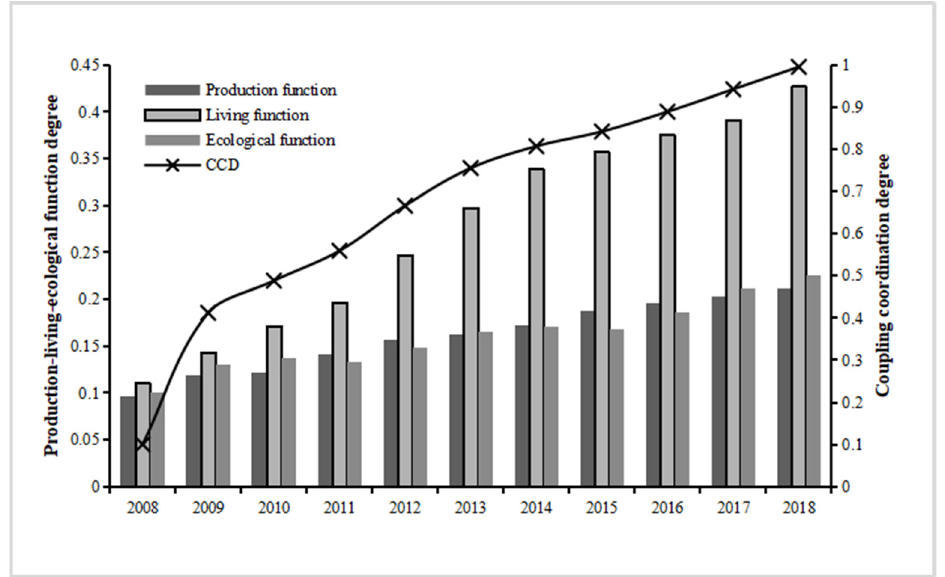
Figure 2. Time series evolution of “production-living-ecological” function coupling and coordination level in the Yellow River Basin.